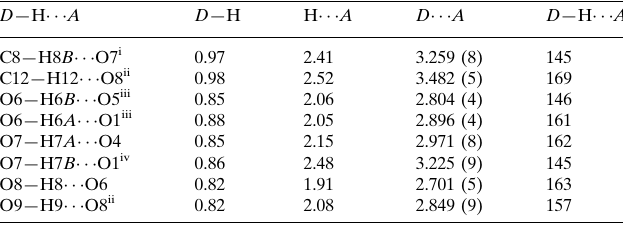
Related literature